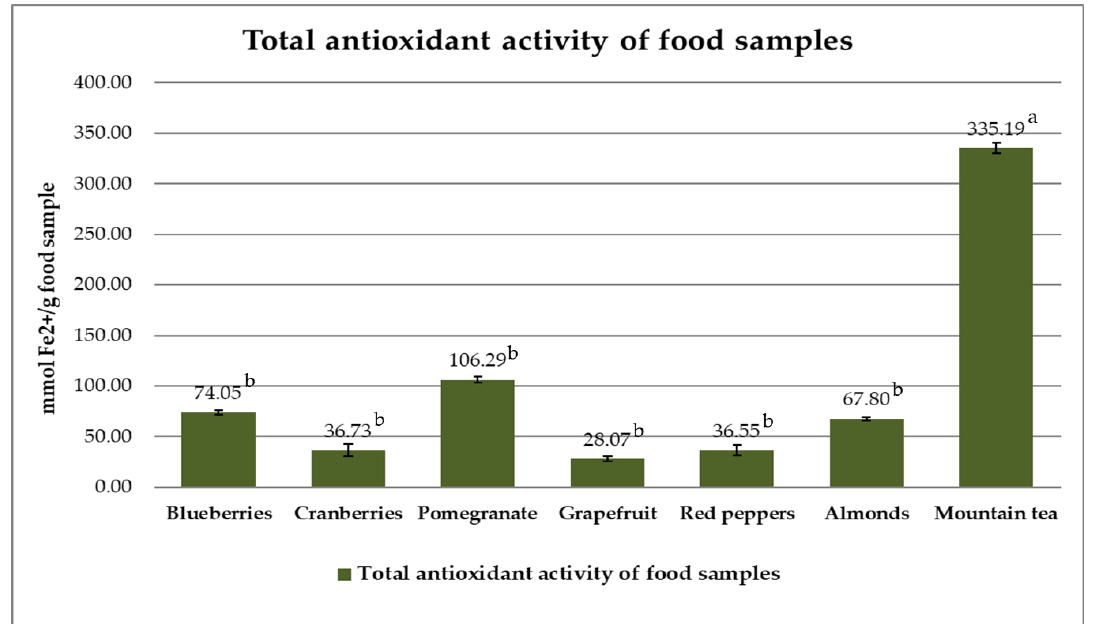
Figure 1. Mean values of total antioxidant activity of different food extracts as determined by Ferric Reducing Antioxidant Power (FRAP) assay. Statistically significant differences are portrayed with superscripts (different letters).